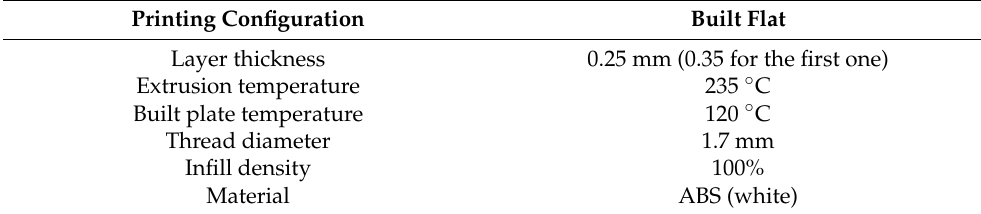
Table 1. Printing settings.